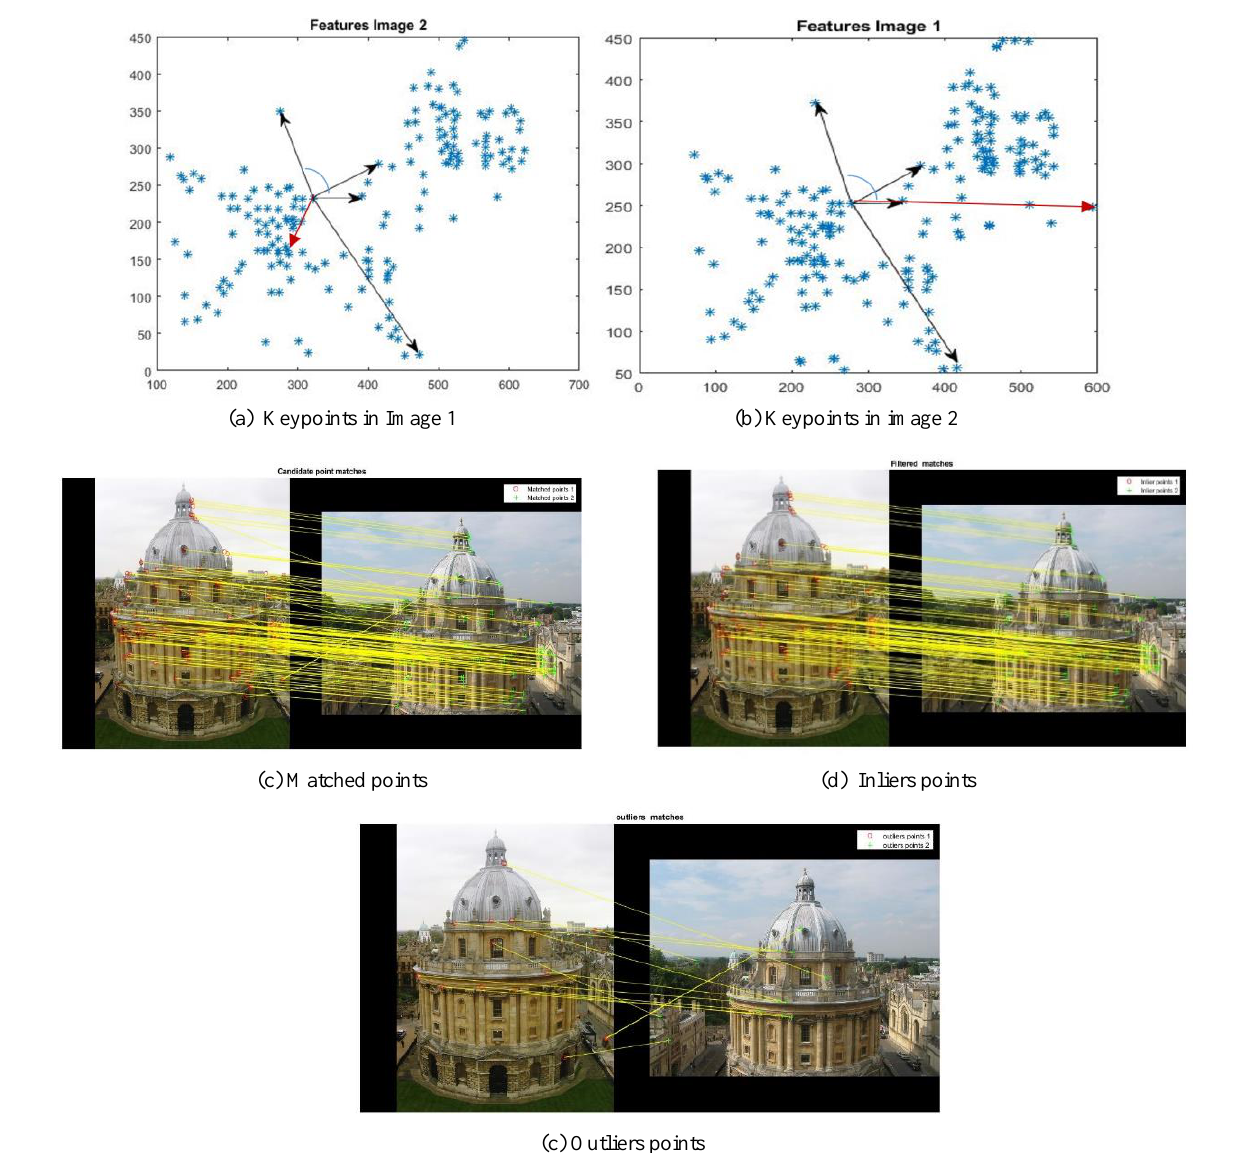
Figure 4. (a) and (b) show the 2D matched points in both images. The distances and the angles are measured between a reference point in the first image and its correspondence in the other image, and then any significant difference will